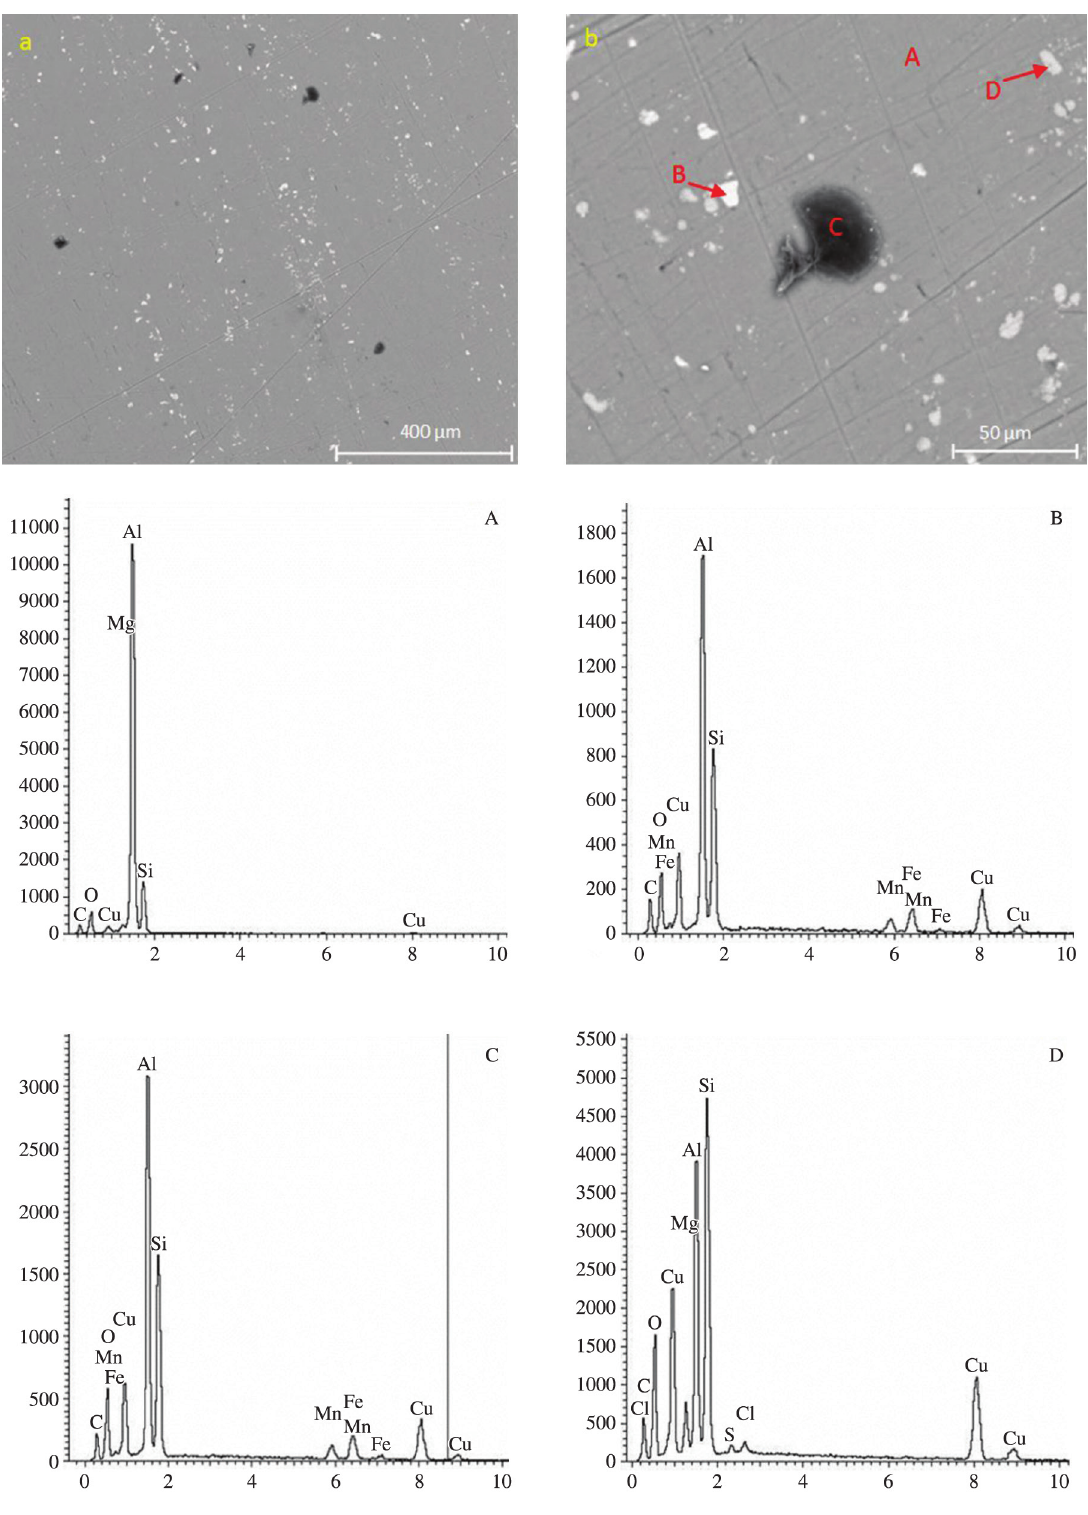
Figure 21. Scanning electron micrograph of the sample containing the film deposited with discharge power of 20 W with amplification of (a) 250 times and (b) 1500 times. A, B, C and D are energy dispersive spectra of the regions A, B, C and D of the micrograph shown in